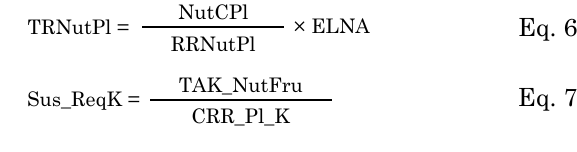
Table 2. Recovery rate of the nutrient by the plant (RRNutPl) for melons in percentage of different nutrients adopted by Ferticalc-melon (1) Nutrient